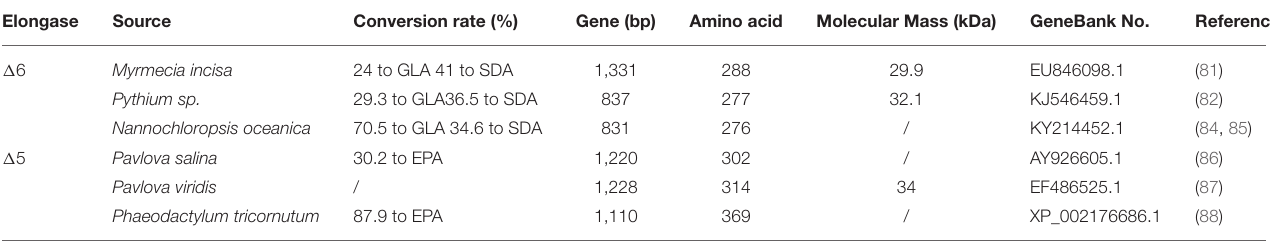
TABLE 4 | The characteristic of the